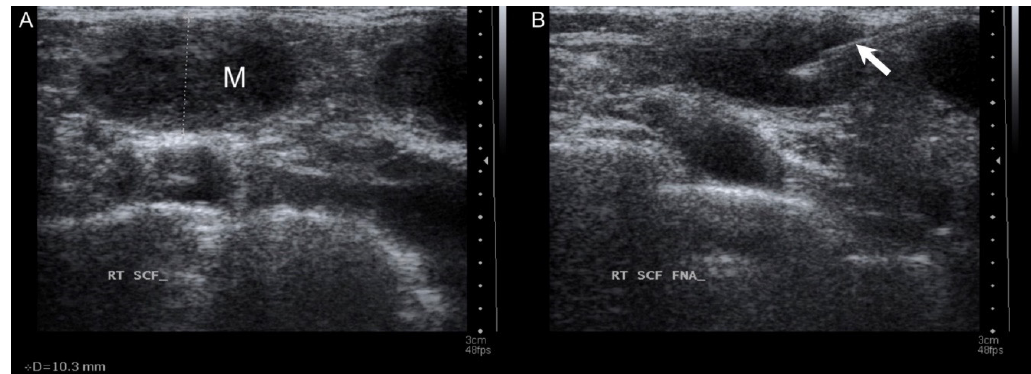
Figure 1. ( A ) Targeted ultrasound revealed an ovoid heterogeneous mass with a short axis of about 10.3 mm. (M: mass); ( B ) fine needle (arrow) aspiration cytology was performed using a 21-gauge needle.